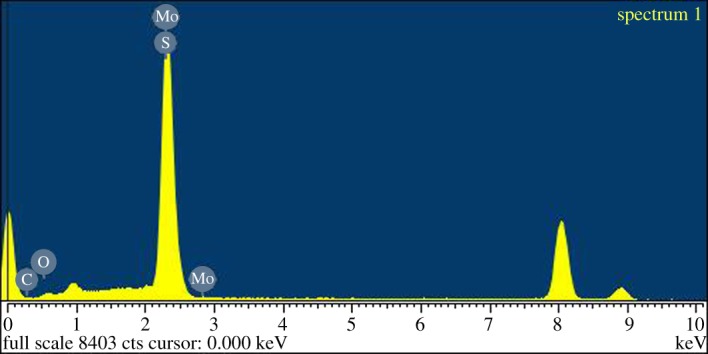
Energy dispersive spectroscopy of PEG@MoS2.